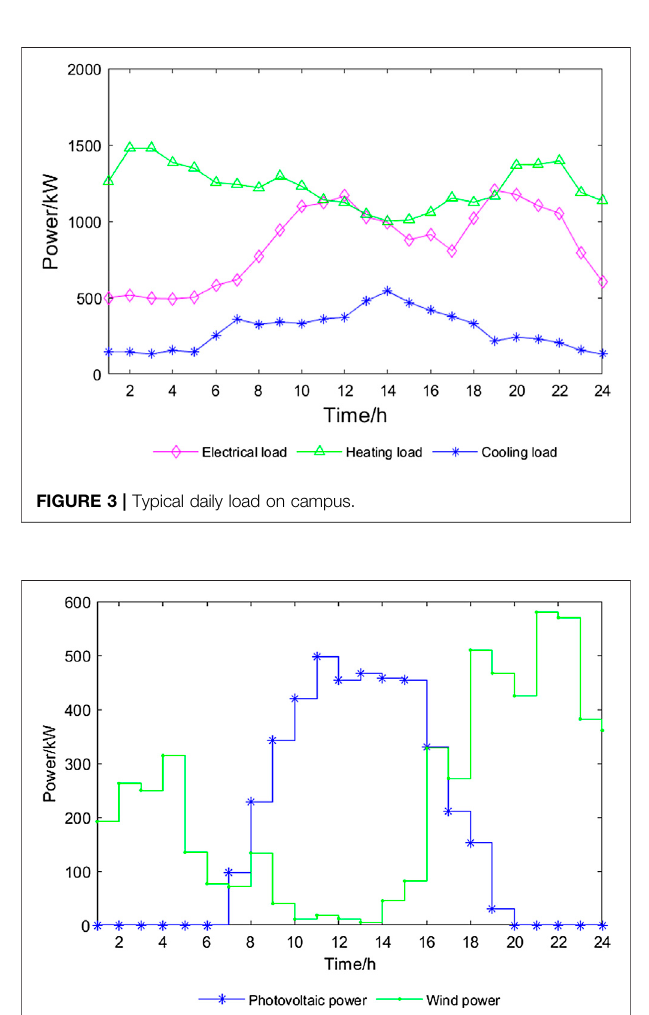
FIGURE 4 | Typical day wind and PV generation forecast.